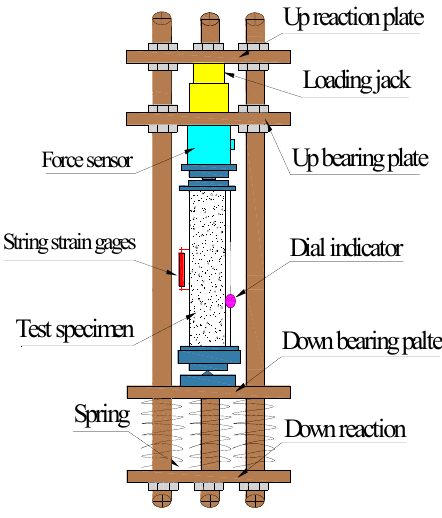
Figure 1. Schematic diagram of the creep test setup. Table 6. Summary of the experimental design on 12 concrete-filled steel tube (CFST)